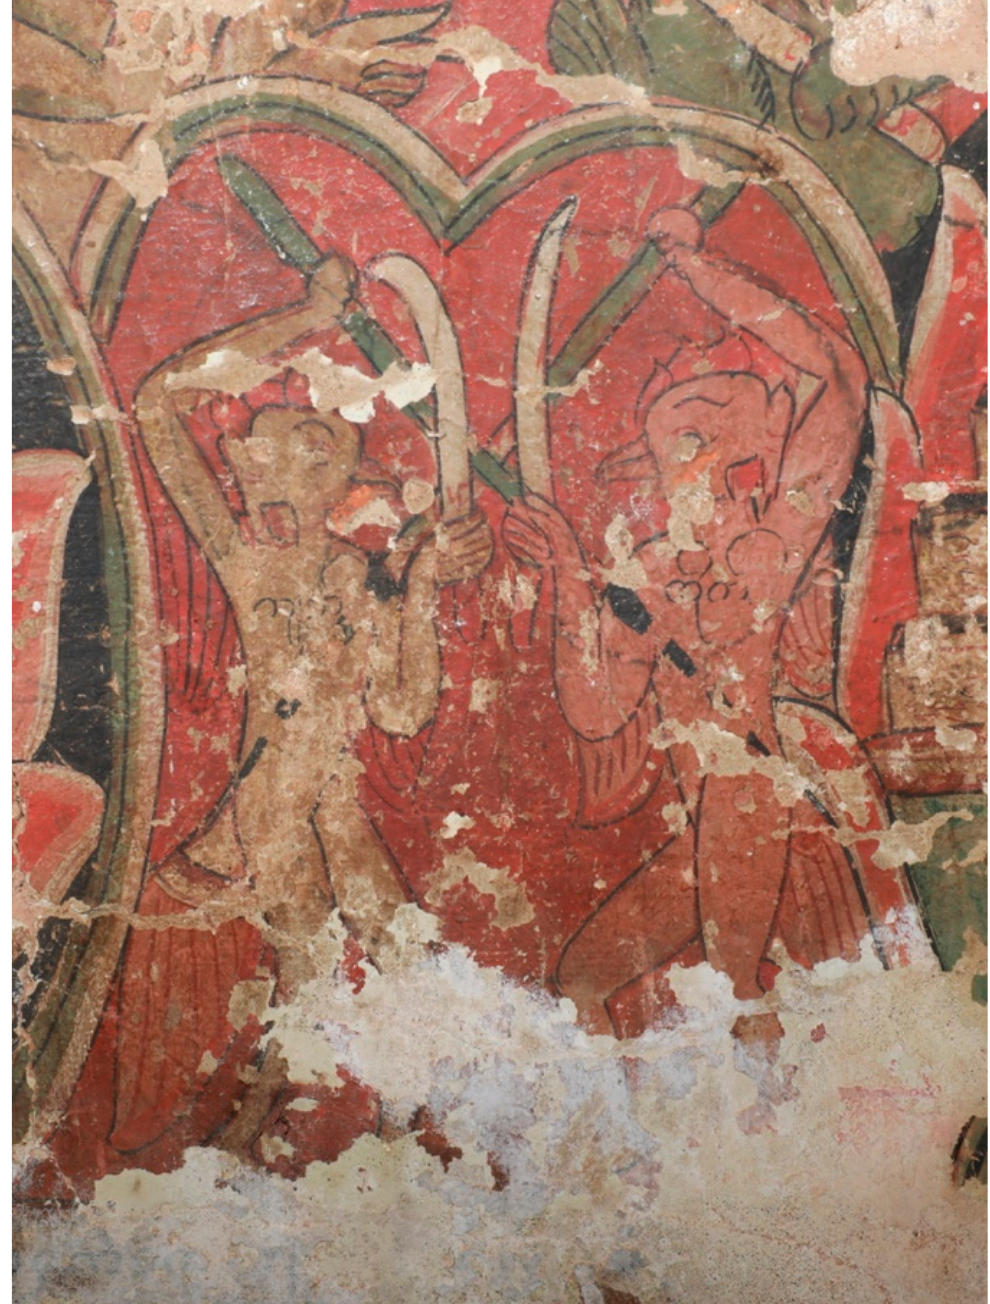
Figure 50. Anaint, 18th century, Punishment for Engaging in Cock Fights.